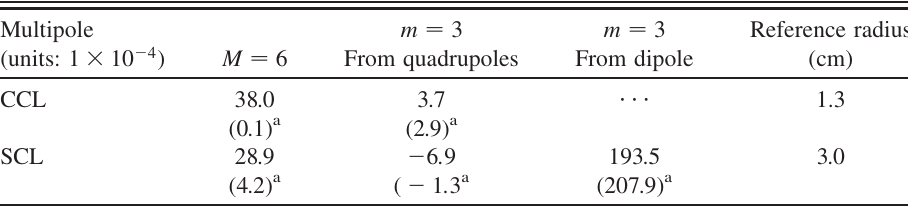
TABLE I. Multipole components of the linac magnets.